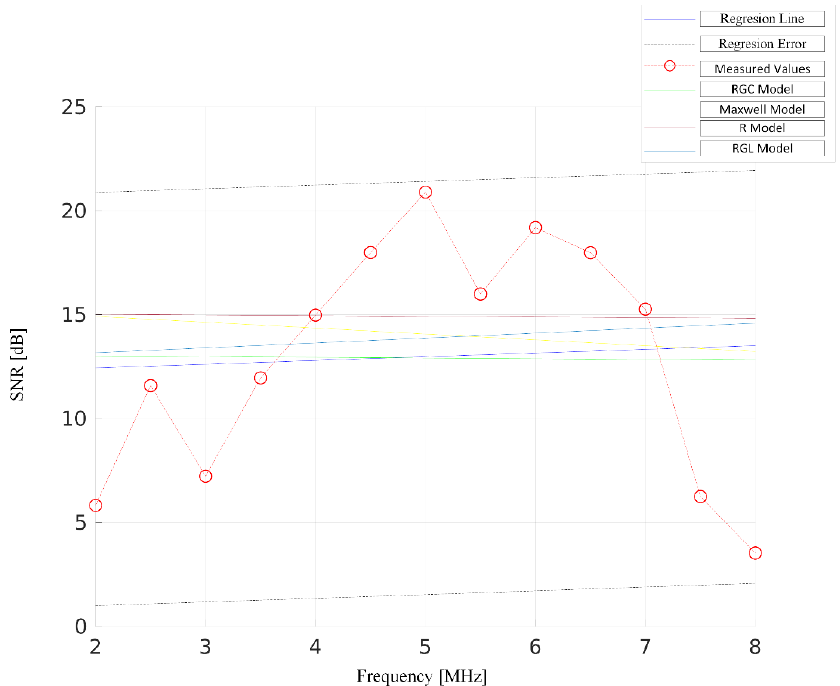
Figure 5. Relation between SNR and frequency for different cable models for capacitive – inductive coupling.